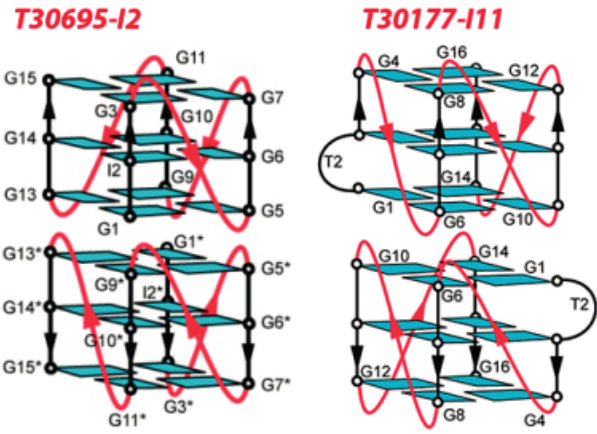
Figure 8. Schematic structures of the dimeric G-quadruplexes adopted by T30695-I2 ( Left ) and T30177-I11 ( Right ) in K + solutions (reproduced respectively from refs. 72 and 73 with permissions of Oxford University